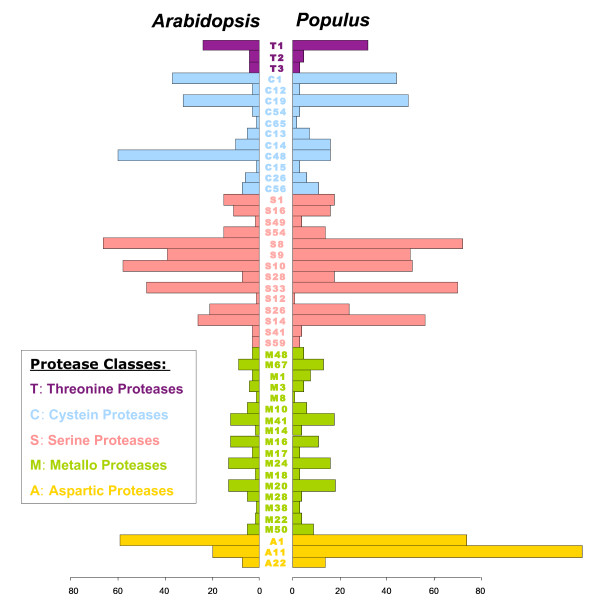
Classification and comparison of proteases in Arabidopsis and Populus. The different colors indicate the different protease classes: threonine proteases (T), cysteine proteases (C), serine proteases (S), metalloproteases (M) and aspartic proteases (A). Each class can be divided into different families according to MEROPS, the family number is indicated between the Arabidopsis and Populus charts.